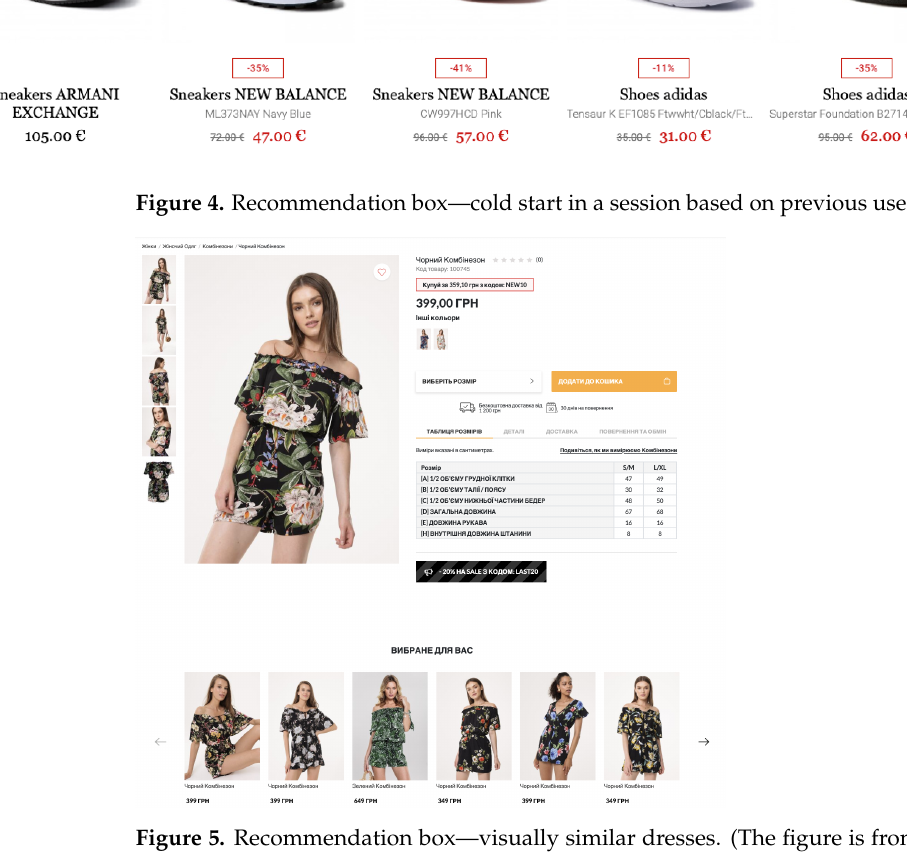
Figure 5. Recommendation box—visually similar dresses. (The figure is from a Polish vendor, so there is a comma instead of a dot in